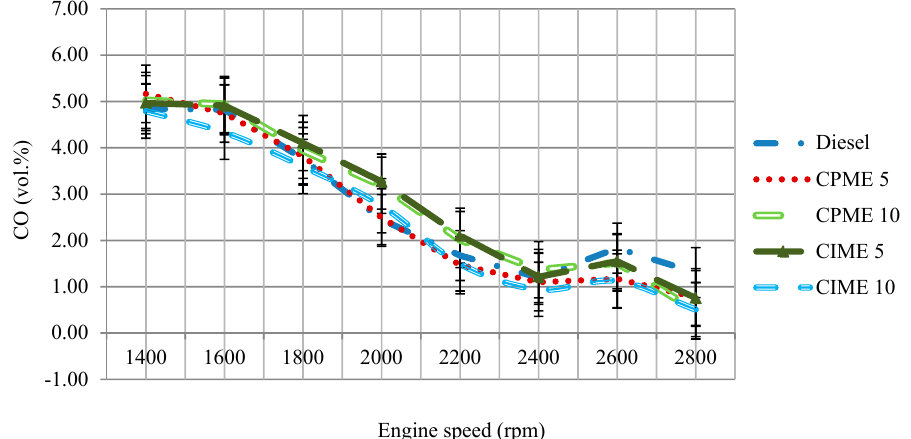
Figure 4. Changes in Carbon Monoxide (CO) emissions of diesel, CPME, and CIME blends with speeds.